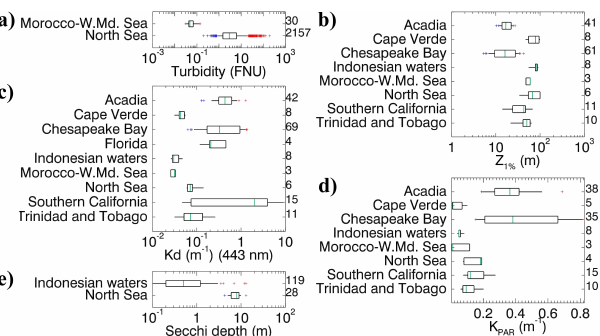
and FTU for Morocco-W. Md. Sea), (b) the photic depth Z 1% (m), (c) Kd at 443nm (m − 1 ), (d) Kpar (m − 1 ), and (e) Secchi depth (m). The scale is logarithmic for turbidity and Kd, and linear elsewhere. The number of measurements taken at each test site is reported on the right axis of the graph. The graphical convention is identical to Fig. 6.